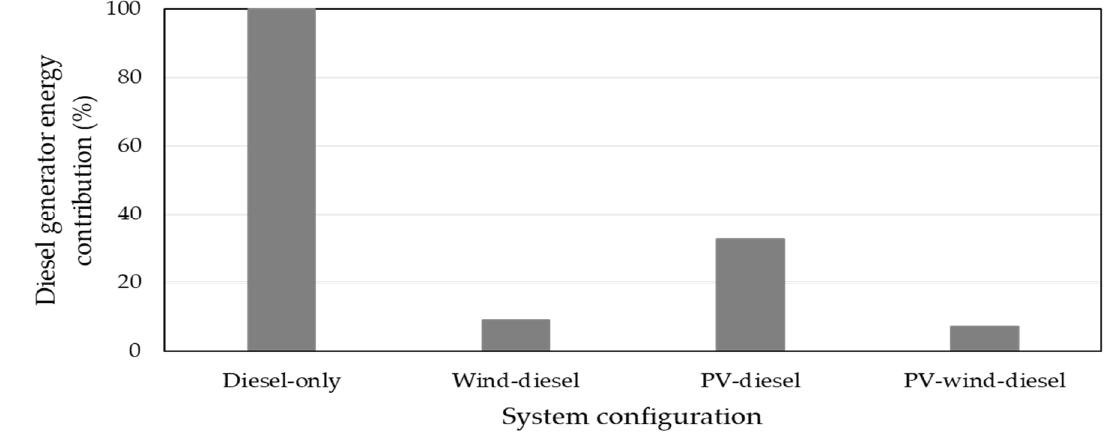
Figure 9. Energy contribution of diesel generator in each system configuration.